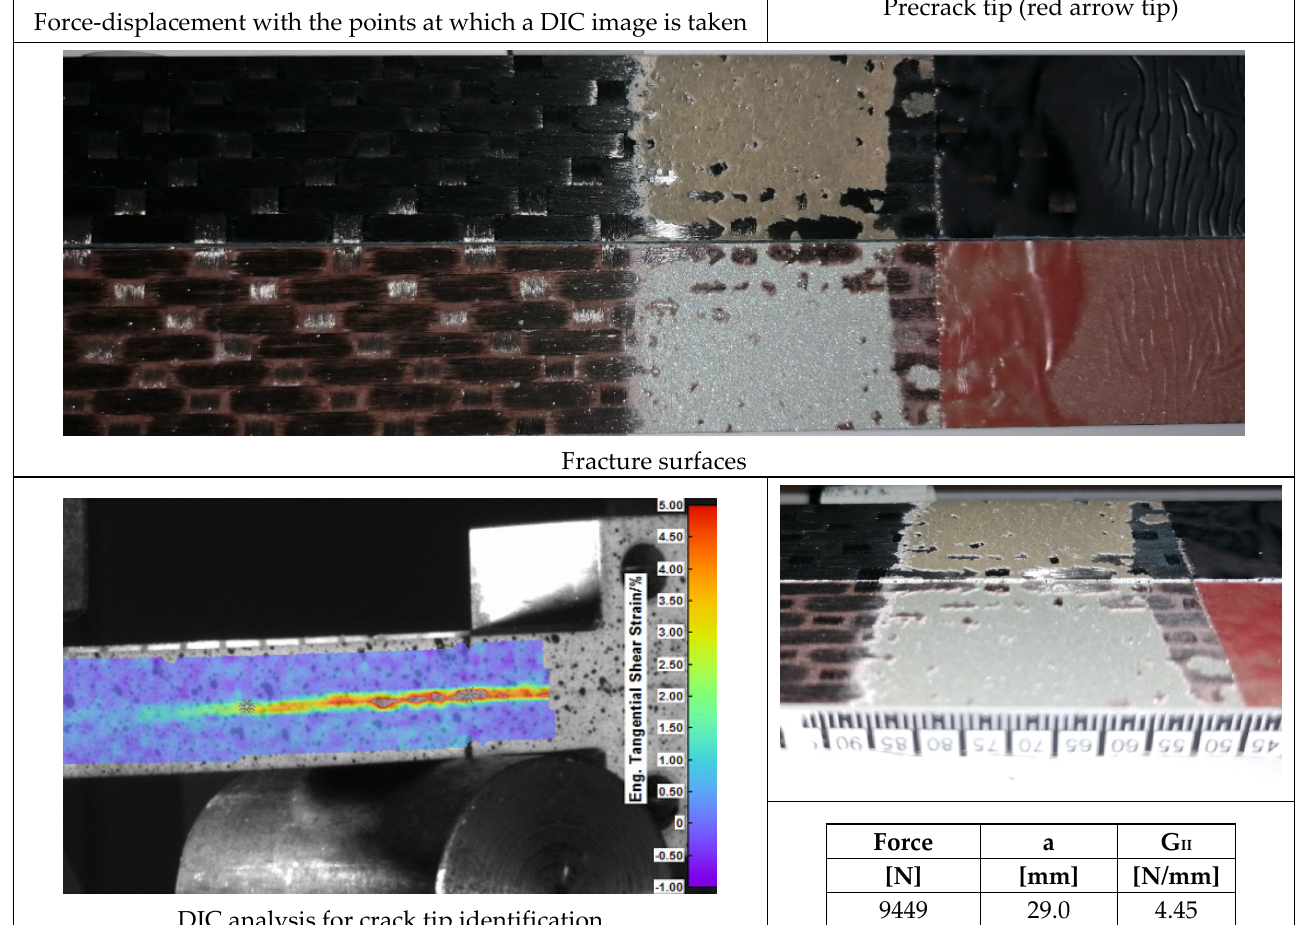
Figure 25. Results of the test on specimen ENF_9323_03.